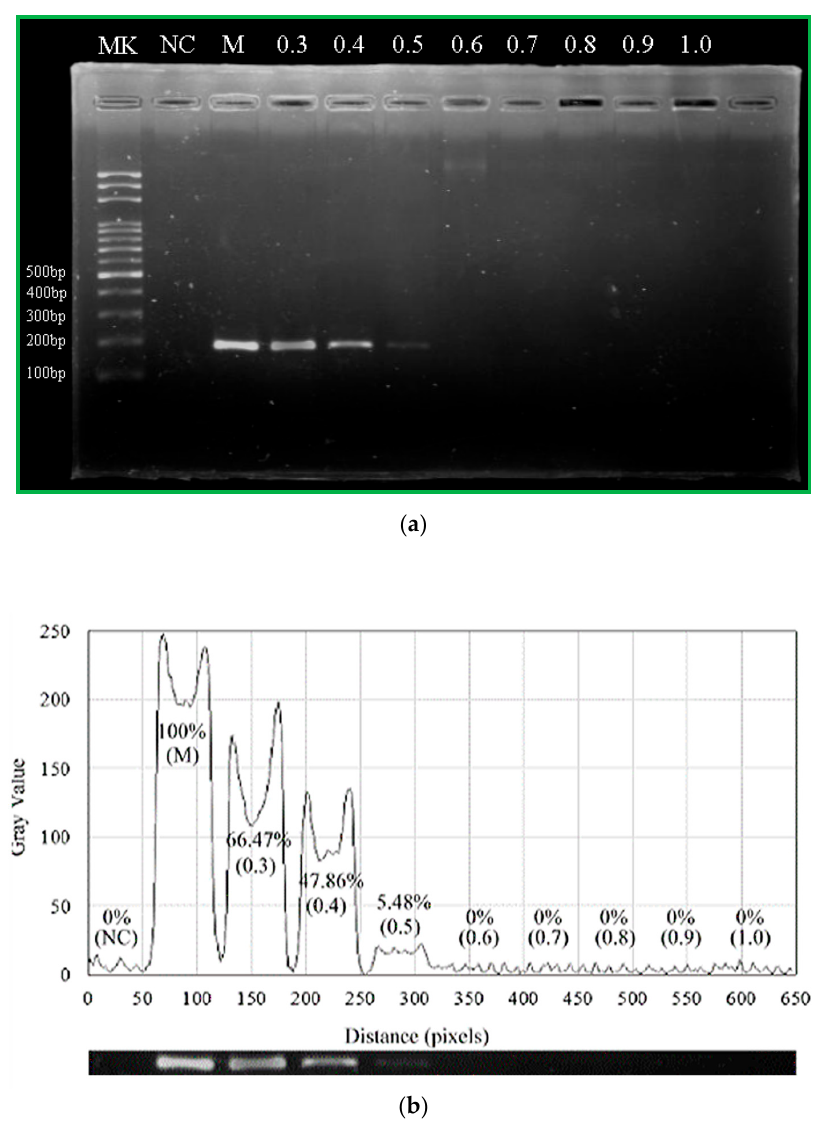
Figure 12. ( a ) The results of gel electrophoresis analysis of the products. The first lane (Lane Mk) indicates the DNA ladder. The second lane (Lane NC) indicates the negative control. The 200 bp PCR product in the commercial PCR machine and CFPCR chip (Lanes M and the others). ( b ) The grey intensities of PCR products by image